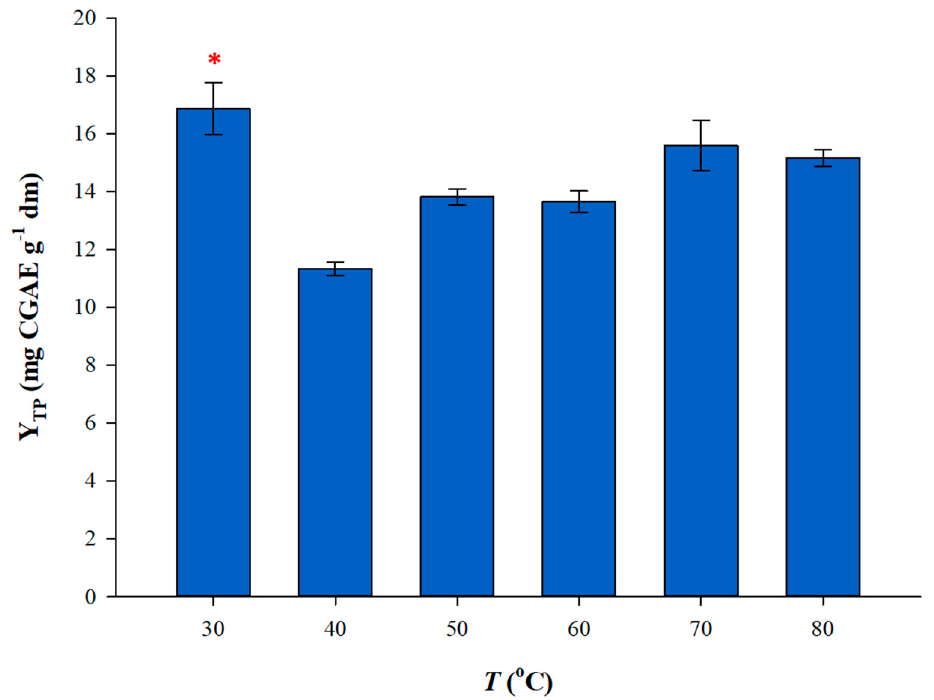
Figure 4. The effect of temperature on total polyphenol yield (Y TP ), under optimized extraction conditions. Asterisk (*) denotes statistically different value ( p < 0.05). All other values showed no statistical difference.